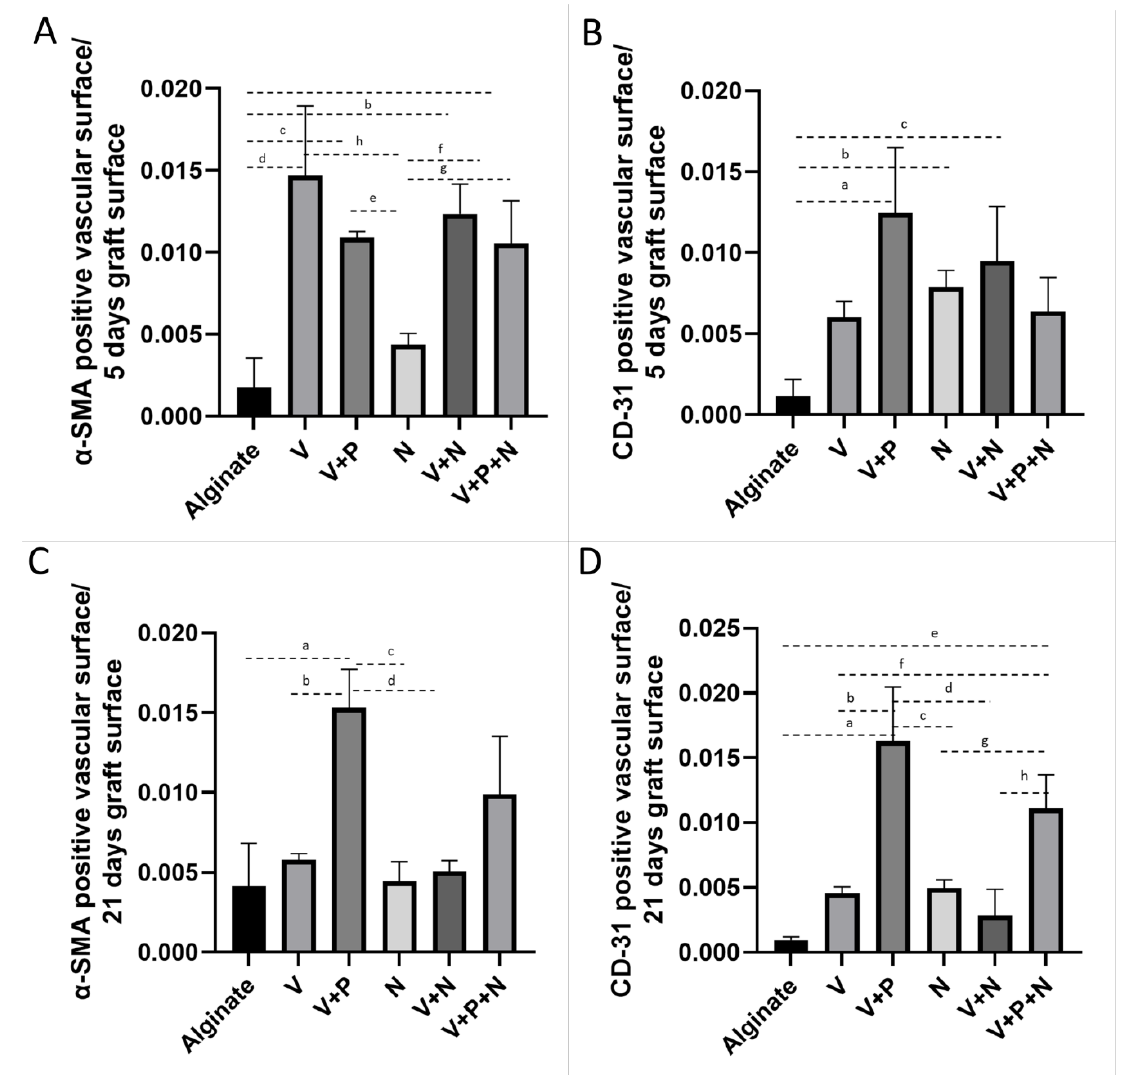
Figure 5. Impact of NP supplementation on the vascularization of mice testicular tissue auto-transplanted for 5 and 21 days. Mouse testicular tissue fragments were encapsulated in alginate supplemented with five different combinations in addition to a negative control (Alginate, V, V+P, N, V+N and V+P+N) and the positive surface for α-SMA (A and C, 5 and 21 days, respectively) and CD31 (B and D, 5 and 21 days, respectively) was quantified using VisioPharm ( n = 36). ( A ) IHC for α-SMA, 5 days. Encapsulation with a matrix containing VEGF-NPs (alone or combined with PDGF-NPs or NECINH-NPs) increased vascular surfaces. Results are expressed as the mean positive vascular surface per total graft surface ± standard deviation: Alginate (1.74 × 10 − 3 ± 1.81 × 10 − 3 ); V (1.47 × 10 − 2 ± 4.21 × 10 − 3 ); V+P (1.09 × 10 − 2 ± 3.29 × 10 − 4 ); N (4.63 × 10 − 3